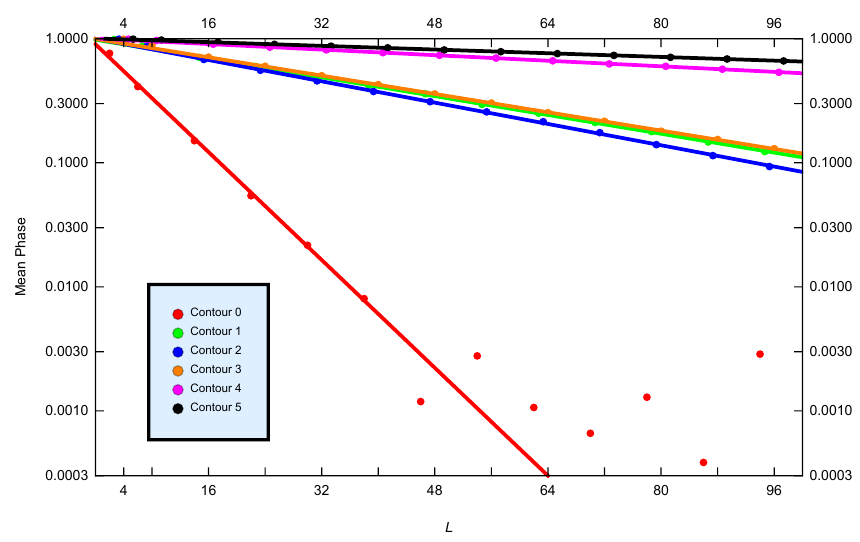
Figure 4 . The mean phase factor as a function of lattice size on a logarithmic scale for the di(cid:11)erent contours together with their linear least square (cid:12)ts. The various contours are colour marked. Di(cid:11)erent contours are separated horizontally for